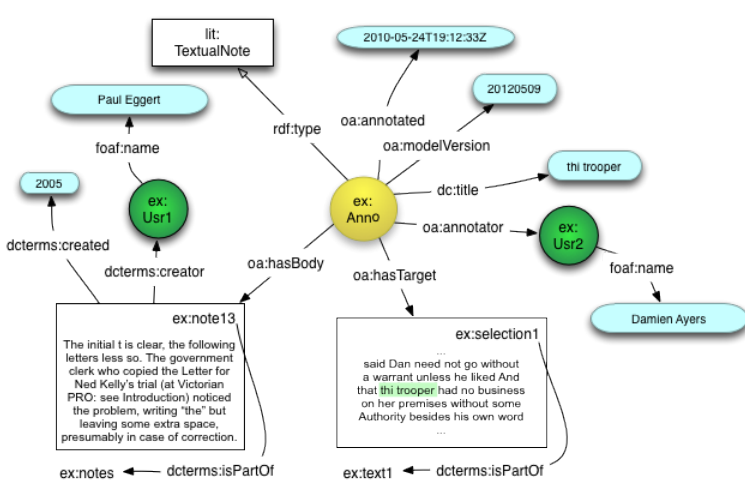
Figure 3. OA instance for textual note.